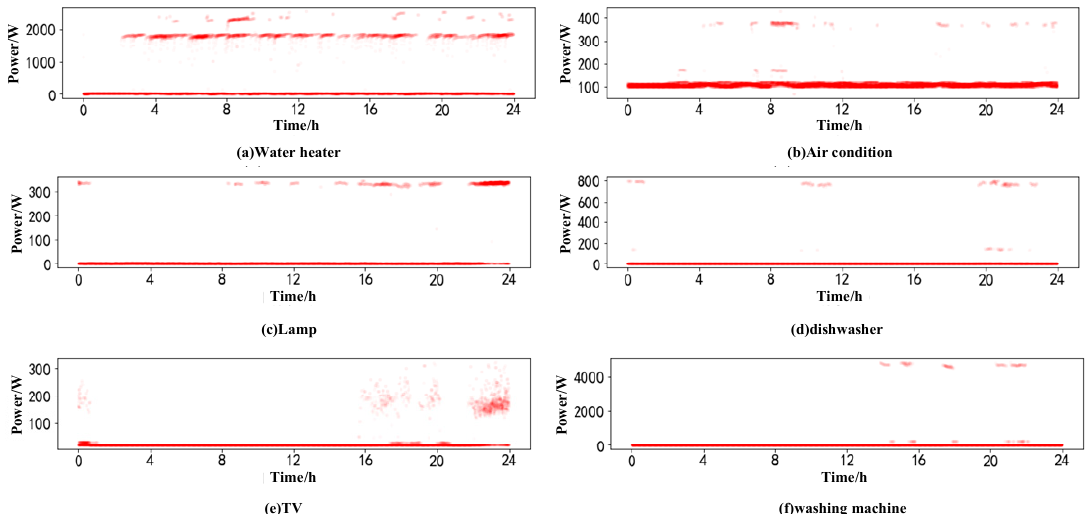
Figure 6. Time distribution of typical load power.